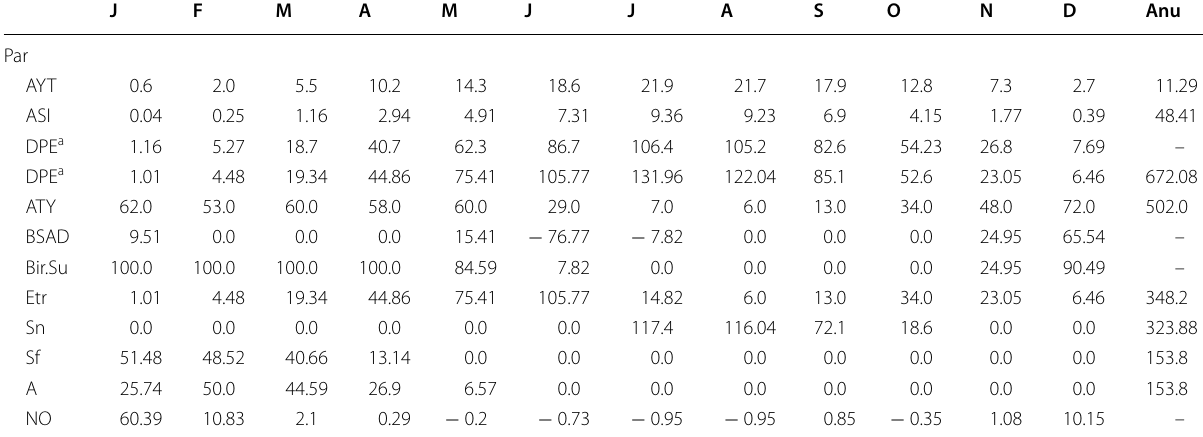
Table 6 Yazıcık Thornthwaite water balance (Çetin 2020)